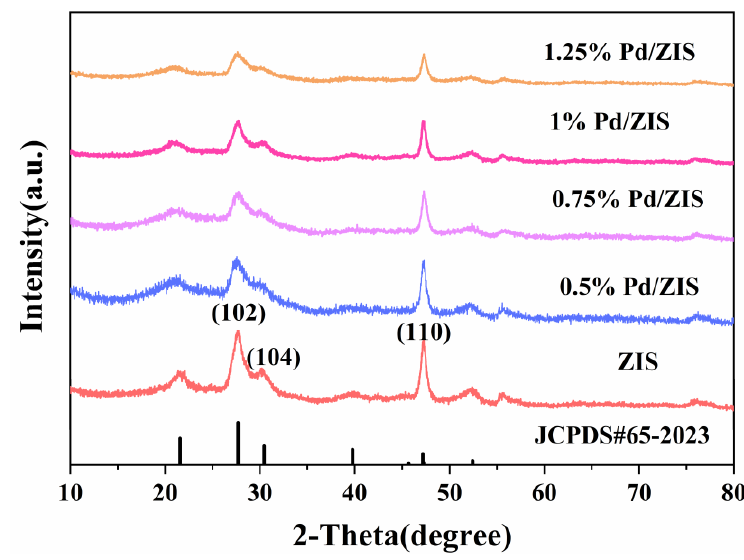
Figure 1. XRD patterns of ZIS and X wt % Pd/ZIS (X = 0.5, 0.75, 1, 1.25).